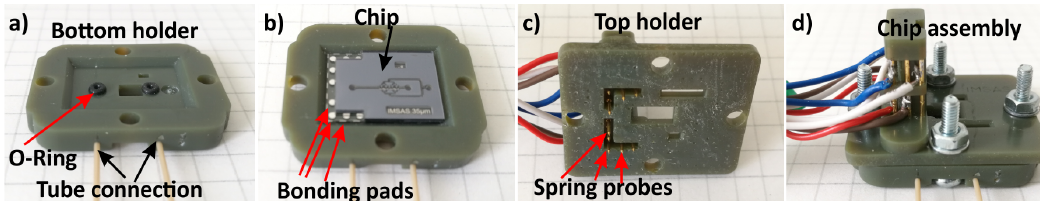
Figure 7. A microfluidic chip holder (21mm × 30mm × 8(21)mm) including three fluidic and nine electric connections. ( a ) The bottom holder part contains doughnut-shaped recesses where O-rings connecting the chip to the channel structure within the printed holder fit. ( b ) A glass-silicon-glass chip (13mm × 17mm × 1.4mm) fitted in the bottom holder. ( c ) The top holder including spring probes to connect the bonding pads of the chip. ( d ) A photo of the assembled chip and holder.